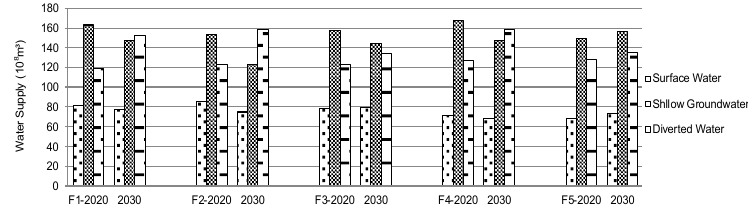
Fig. 3 The composition of main water supply from each scheme in 2020 and 2030.